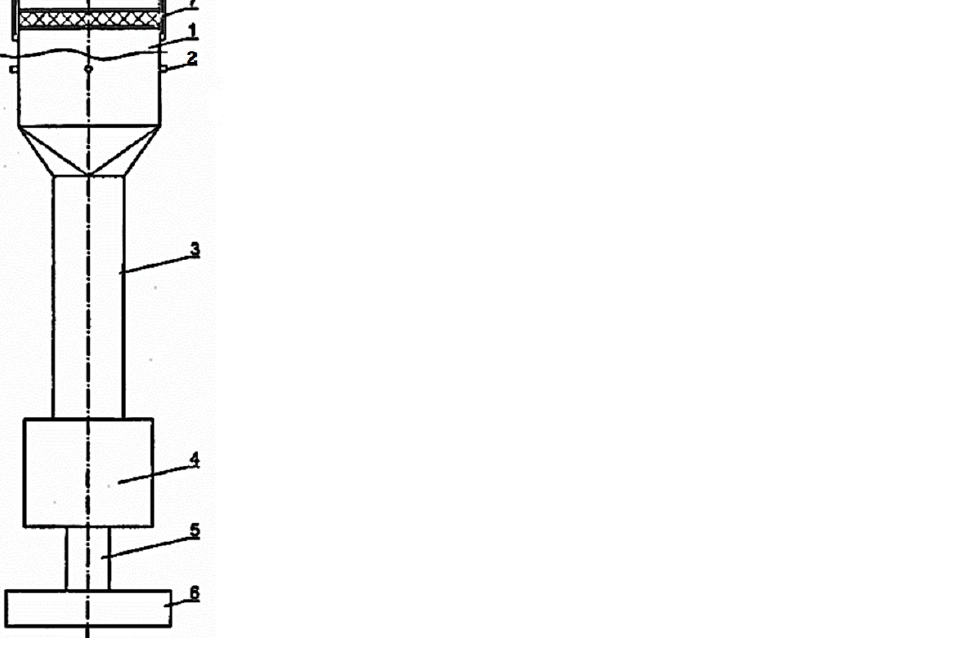
Figure 21. A schematic diagram of the device for measuring the air permeability of high-porosity 3D materials, (1—measuring head, 2—placement of the pressure drop device, 3—pipeline, 4—equalizer tank, 5—suction pipeline, 6—device forcing air flow through sample, 7—pipe section).